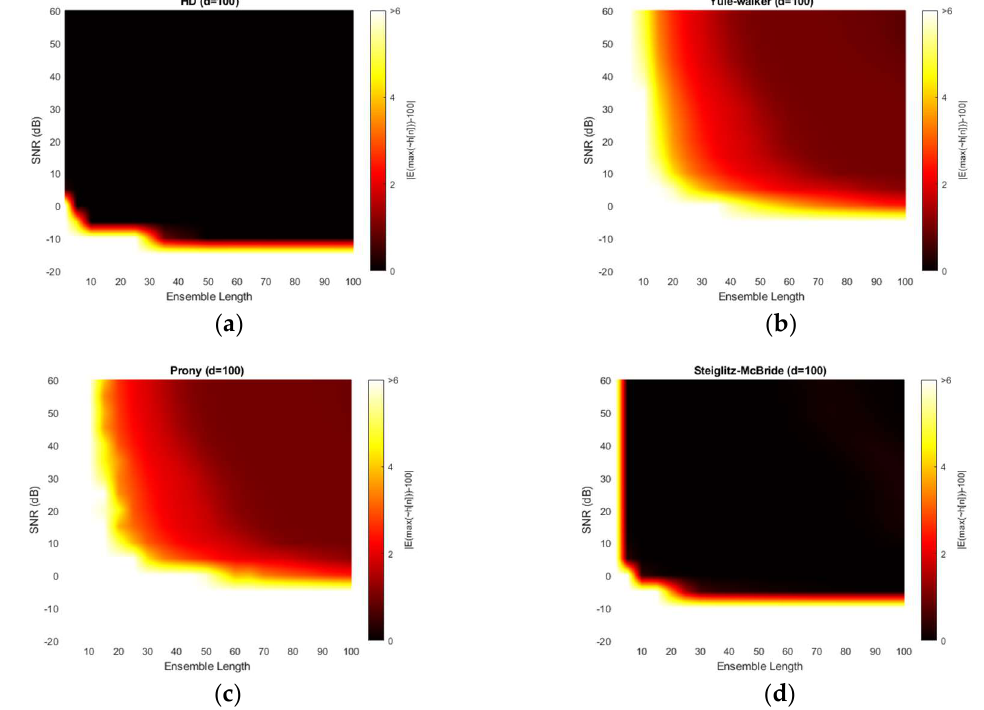
Figure 13. Average estimation error with given ensemble average length & SNR for 100-sample delay: ( a ) non-parametric HD; ( b ) Yule-walker HD; ( c ) Prony HD; ( d ) Steiglitz-McBride HD.